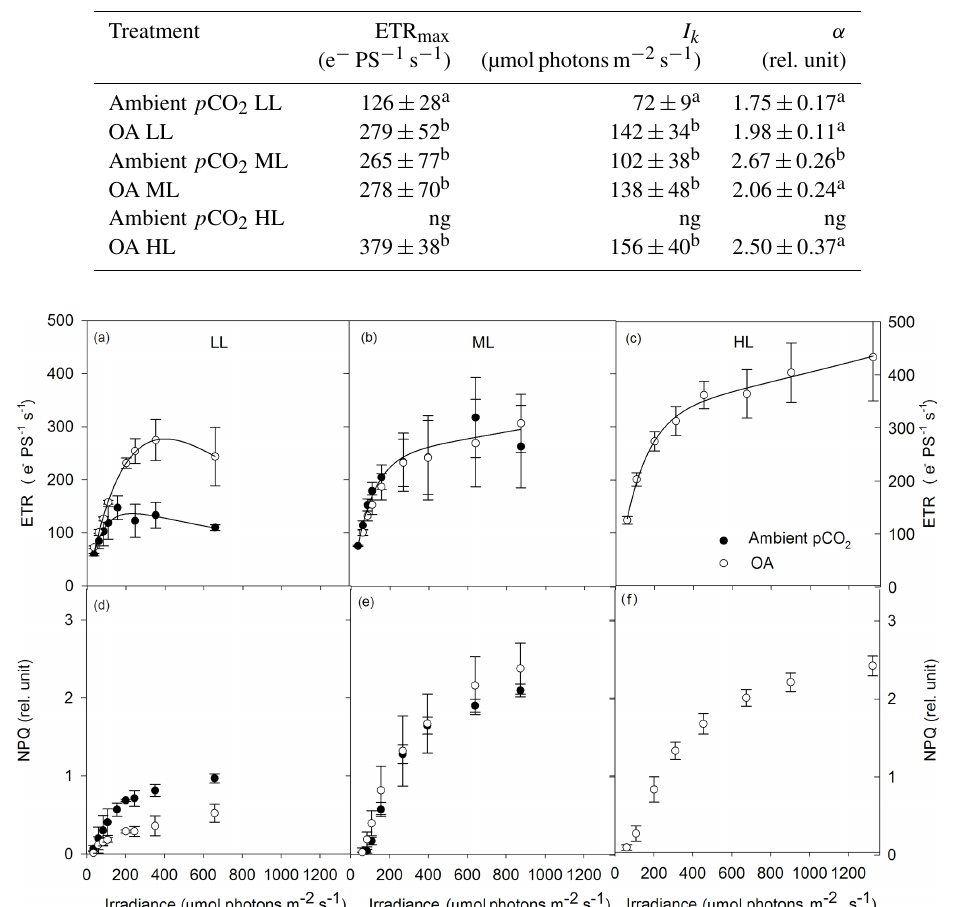
Table 3. Maximum absolute electron transport rates (ETR max ), minimum saturating irradiances ( I k ) and maximum light utilization efficien- cies ( α ) were determined for Geminigera cryophila acclimated to ambient or high CO 2 conditions combined with low (LL), medium (ML) or high light (HL). G. cryophila did not grow under ambient p CO 2 and HL as indicated by ng. Photosynthetic parameters were derived from at least three independent measurements. Different letters indicate significant differences between treatments ( p < 0 . 05). Values represent the means ± SD.